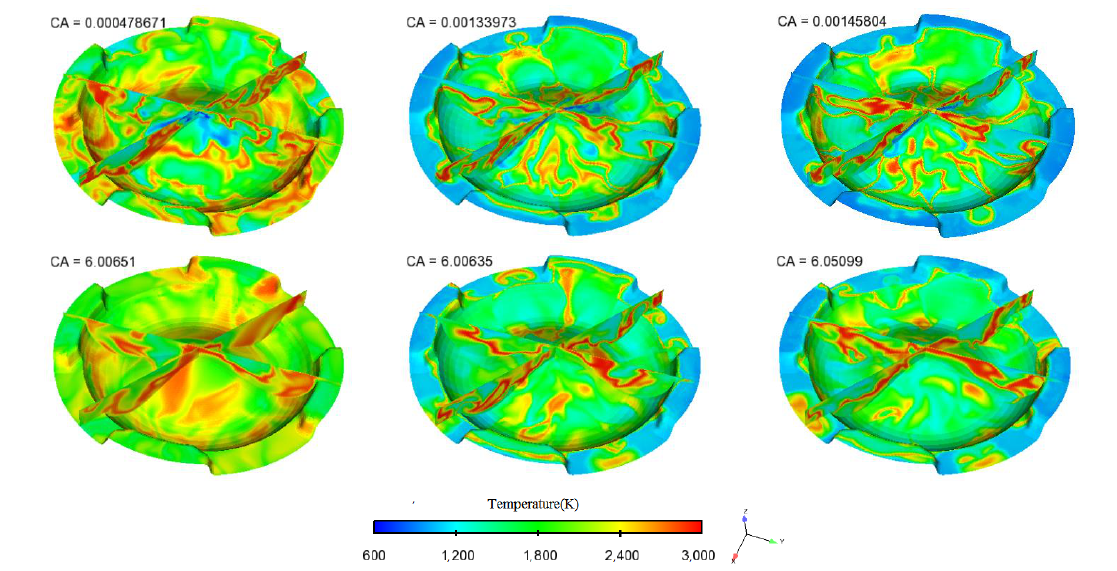
Figure 19. Comparison of temperature distribution at various altitudes.